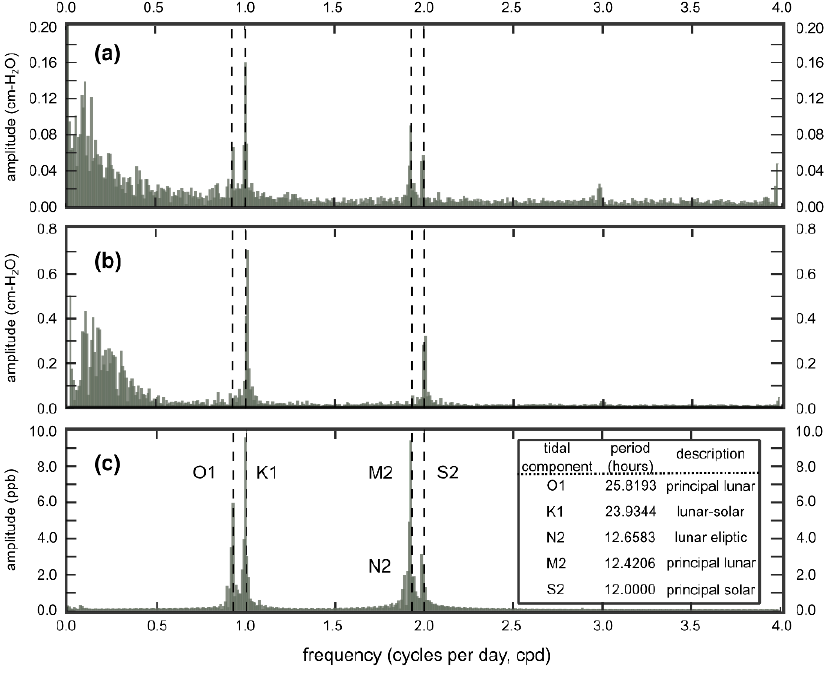
amplitude spectra for Fourier transform of barometric pressure (expressed as the equivalent column of